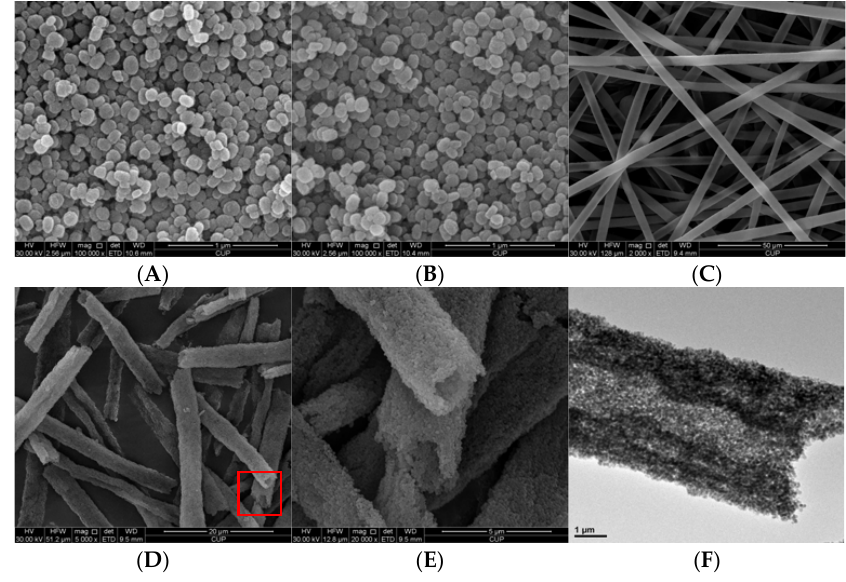
Figure 3. SEM images of the as-prepared Nano-ZSM-5 ( A ); 0.3% Ga 2 O 3 /ZSM-5 ( B ); 0.3% Ga 2 O 3 /ZSM-5/PVP fibers before calcination ( C ); the low ( D ) and magnified ( E ) SEM images of 0.3% Ga 2 O 3 /ZSM-5 hollow fibers after calcination at 550 °C, respectively; TEM image ( F ) of one hollow fiber after calcination at 550 °C.